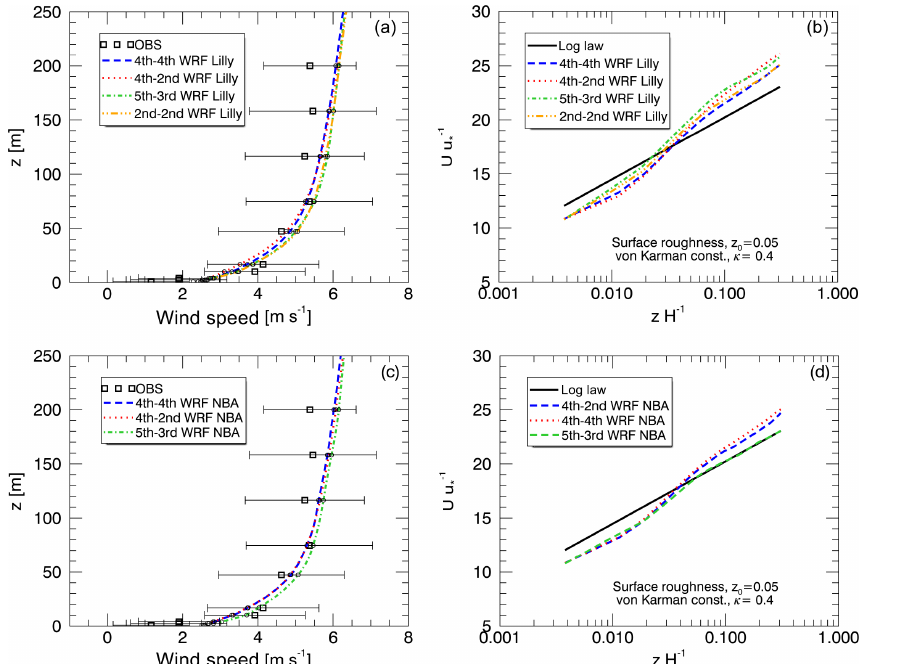
Figure 8. Impacts of varying advection schemes and SFS models in WRF, on simulated profiles of time-averaged wind speed plotted against observations (a, c) and the theoretical logarithmic profile shape (b, d) , from the neutral case study. Simulations used Lilly (a, b) and NBA (c, d) SFS parameterizations.